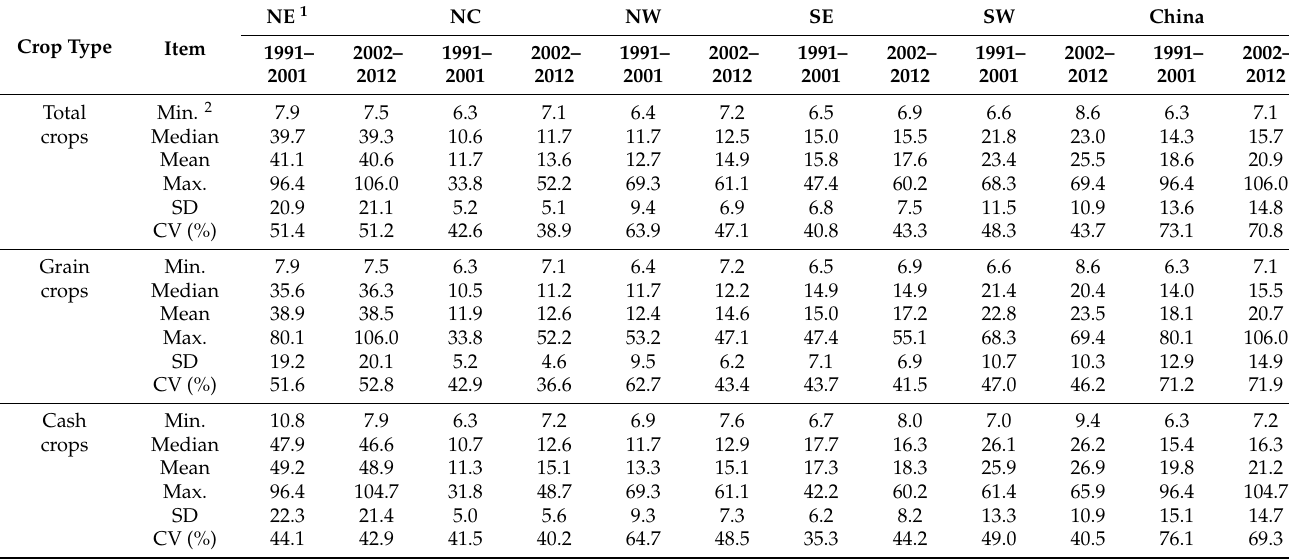
Table 3. Estimated changes of soil organic carbon density (SOCD) between the 1991–2001 and the 2002–2012 from different geographical regions in China’s croplands.